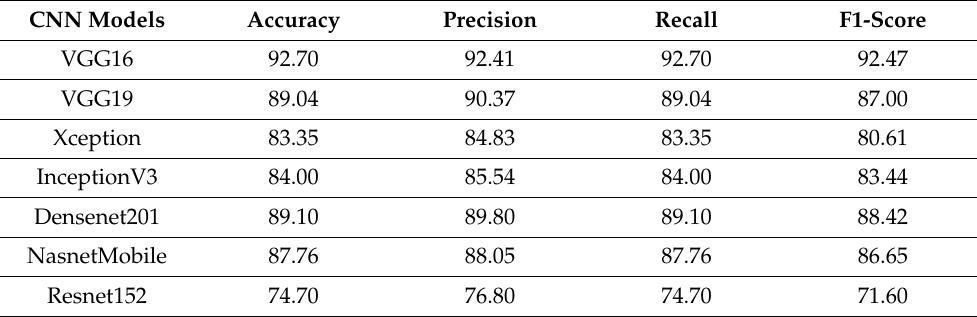
Table 7. Weighted average of performance metrics by different deep learning models for five-class classification into COVID-19, viral pneumonia, bacterial pneumonia, tuberculosis, and normal. CNN